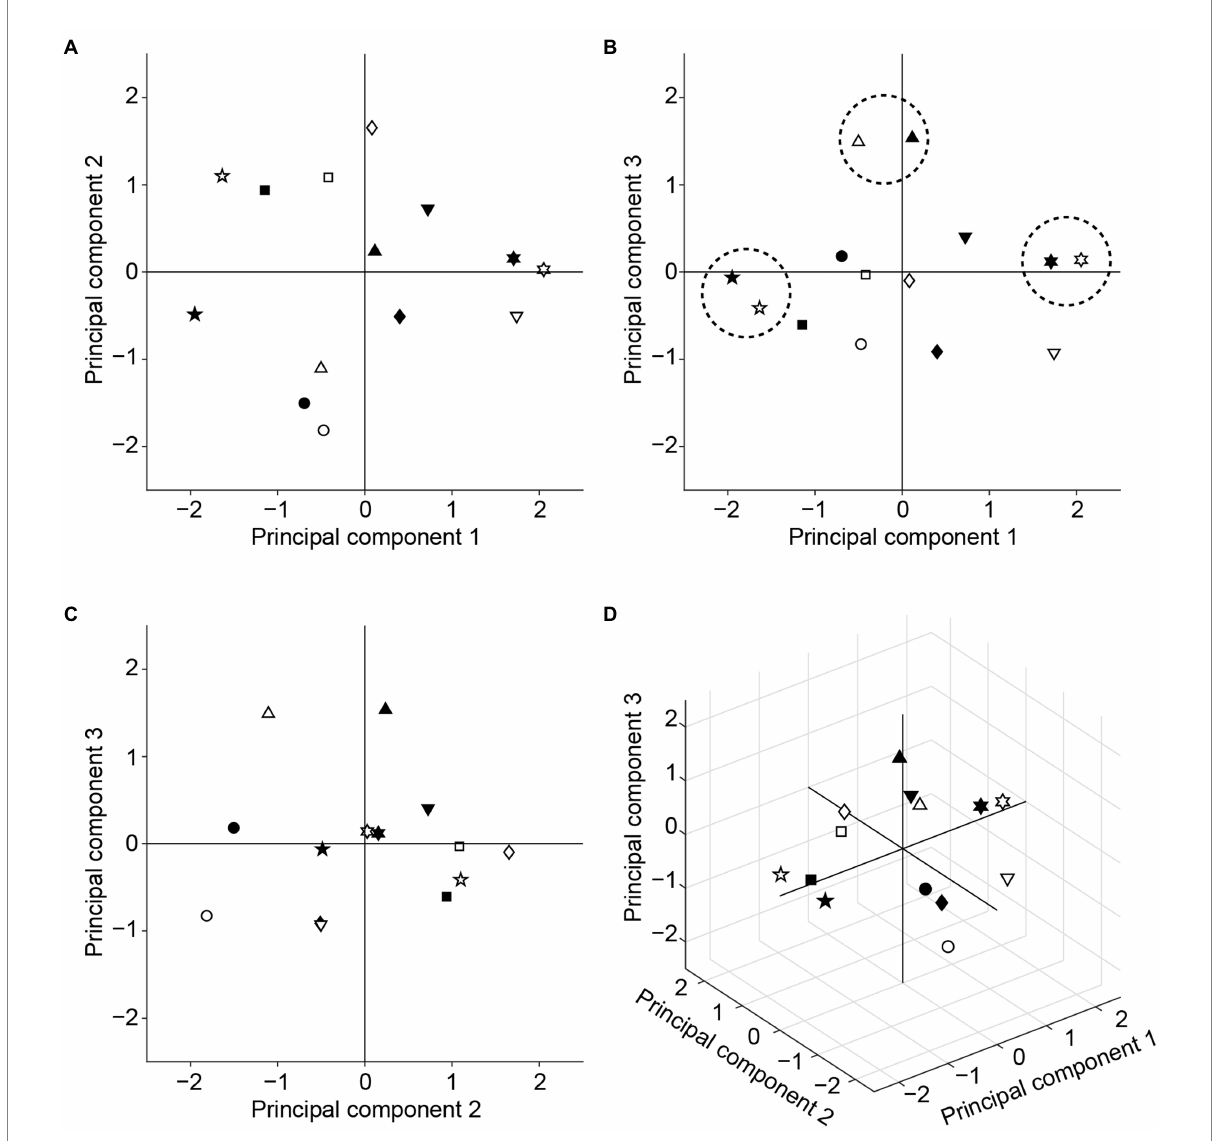
FIGURE 10 Principal component analysis of the AU selectivity of the computational units in the FC3 layer. Distribution of the response profiles of the facial expressions in two-dimensional spaces spanned by principal components 1 and 2 (A) , principal components 1 and 3 (B) , and principal components 2 and 3 (C) . The distribution in the three-dimensional space is shown in (D) . Symbols with different shapes denote different facial expressions. Circles: neutral; upward-pointing triangles: happy; squares: fearful; diamonds: sad; downward-pointing triangles: angry; pentagons: surprised; hexagons: disgusted. Filled and open symbols indicate data from the KDEF-trained and KRC-trained CNNs, respectively. In (B) , the closely located pairs of expressions between the two databases (neutral, disgusted, surprised) are encircled by dashed